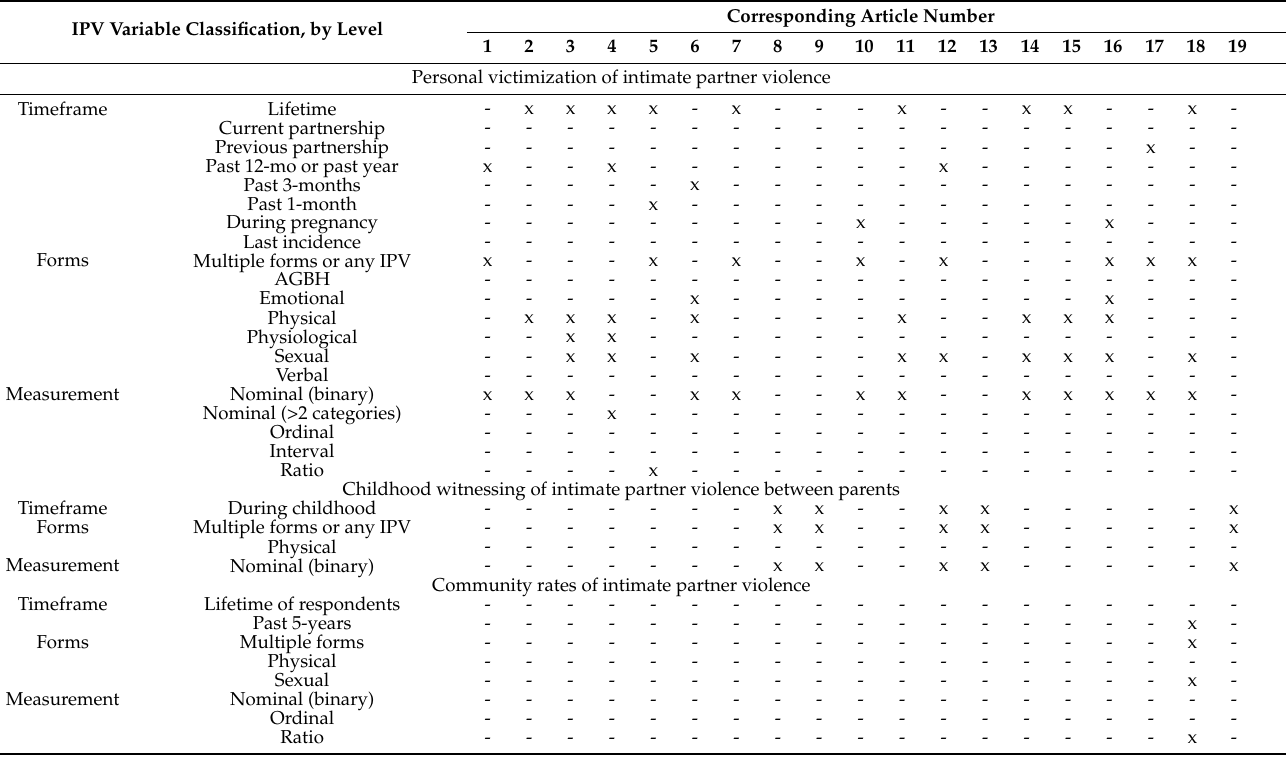
Table 3. Classification of intimate partner violence as independent variable(s), per study. IPV Variable Classification, by